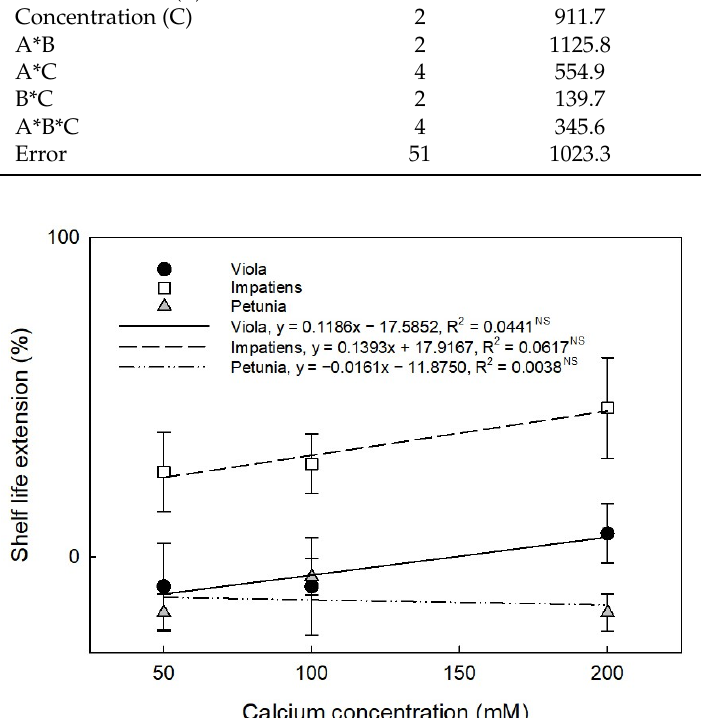
Figure 1. Influence of calcium concentration on shelf life extension of V. cornuta (viola), I. walleriana (impatiens), and P. grandiflora (petunia) in spray application. Each data point represents the mean of shelf life extension from CaCl 2 and Ca(NO 3 ) 2 , but the analysis was performed with all data (n = 8). Bars represent standard error. NS, nonsignificant.